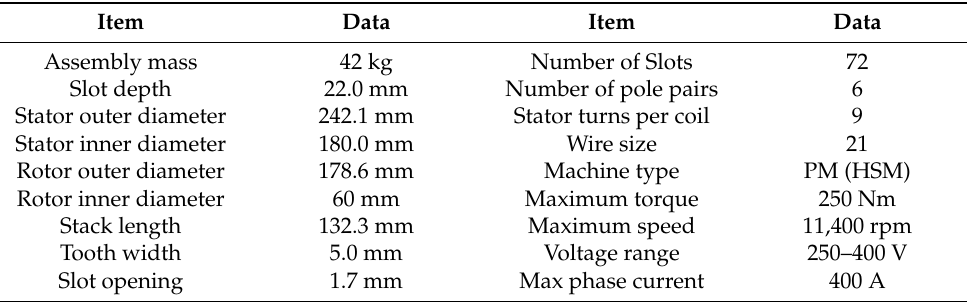
Table 3. Electric motor parameters used in Altair FluxMotor program.